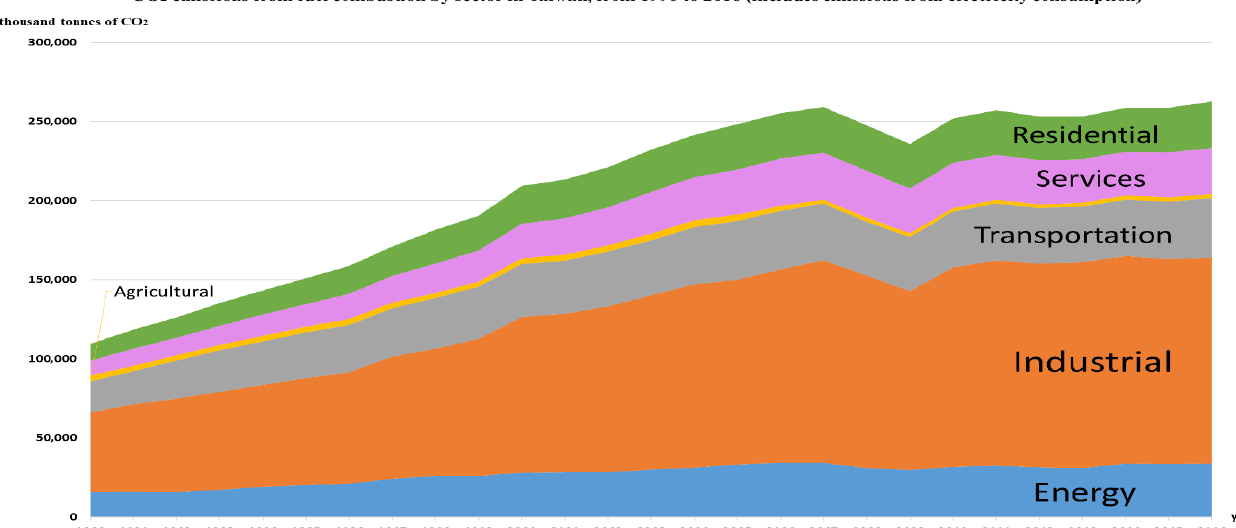
Figure 3. The overall CO 2 emission trends in Taiwan during the 1990–2016 period. Source: made by authors.